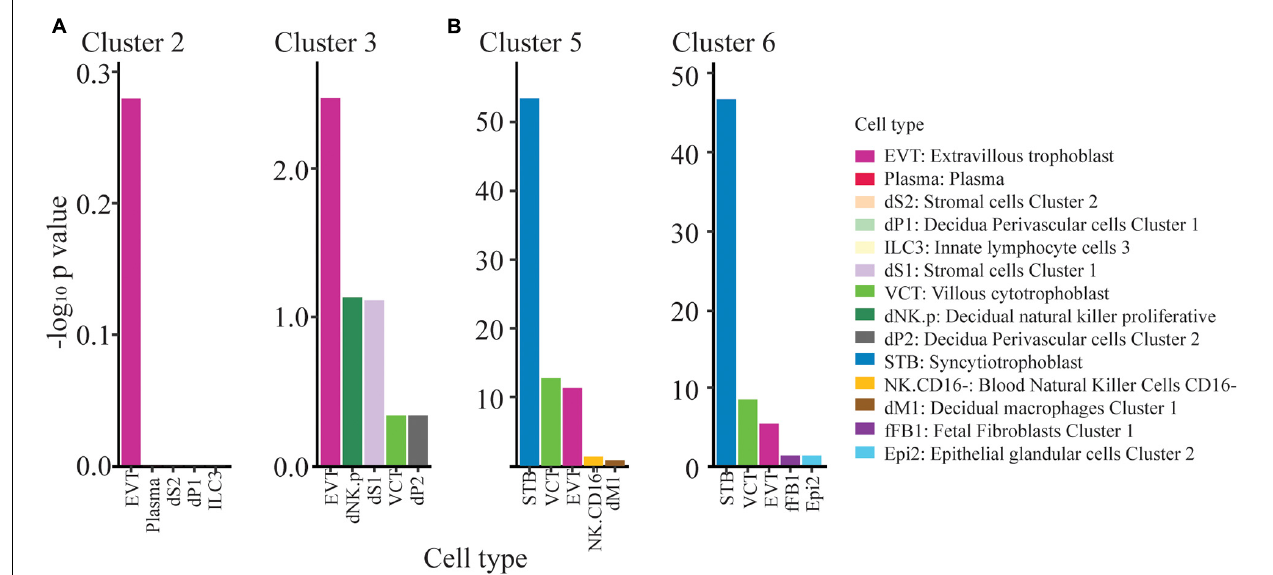
FIGURE 3 | ExtravillousTB and syncytioTB gene enriched clusters. (A) Clusters 2 and 3 show weak enrichment for ExtravillousTB specific markers. (B) Clusters 5 and 6 show strong enrichment for SyncytioTB specific markers. Top 5 cell type results from PlacentaCellEnrich have been shown here for clusters 2,3,5, and 6. The y-axis corresponds to − log 10 of the adjusted